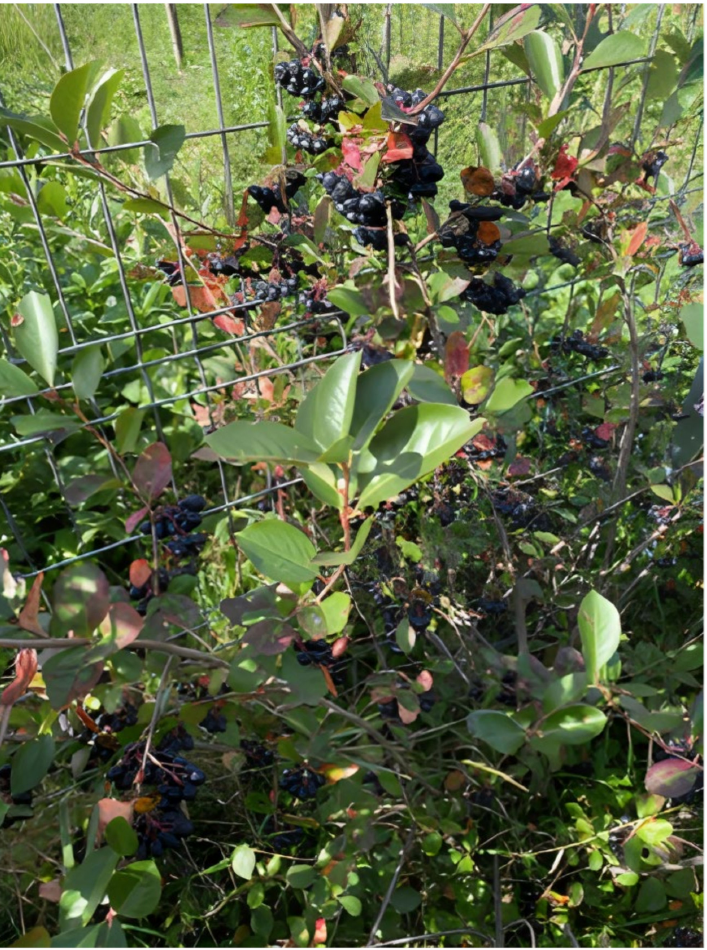
Figure 3. The fruit of A. melanocarpa growing in Ion ă s county,